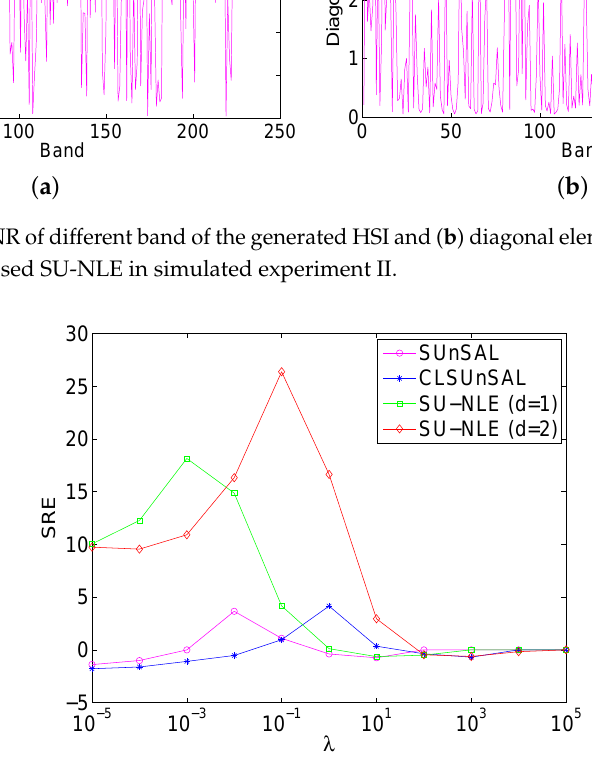
Figure 9. Signal-to-reconstruction errors (SREs) of the methods SU-NLE, SUnSAL and CLSUnSAL as a function of varying regularization parameter λ under Gaussian white noise with only mixed regions having 64 × 64 pixels, 4 endmembers and 224